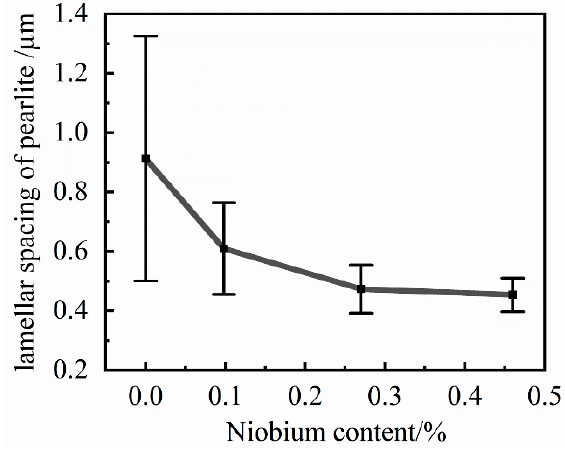
Figure 11. The refinement trend graph of the lamellar spacing of pearlite.